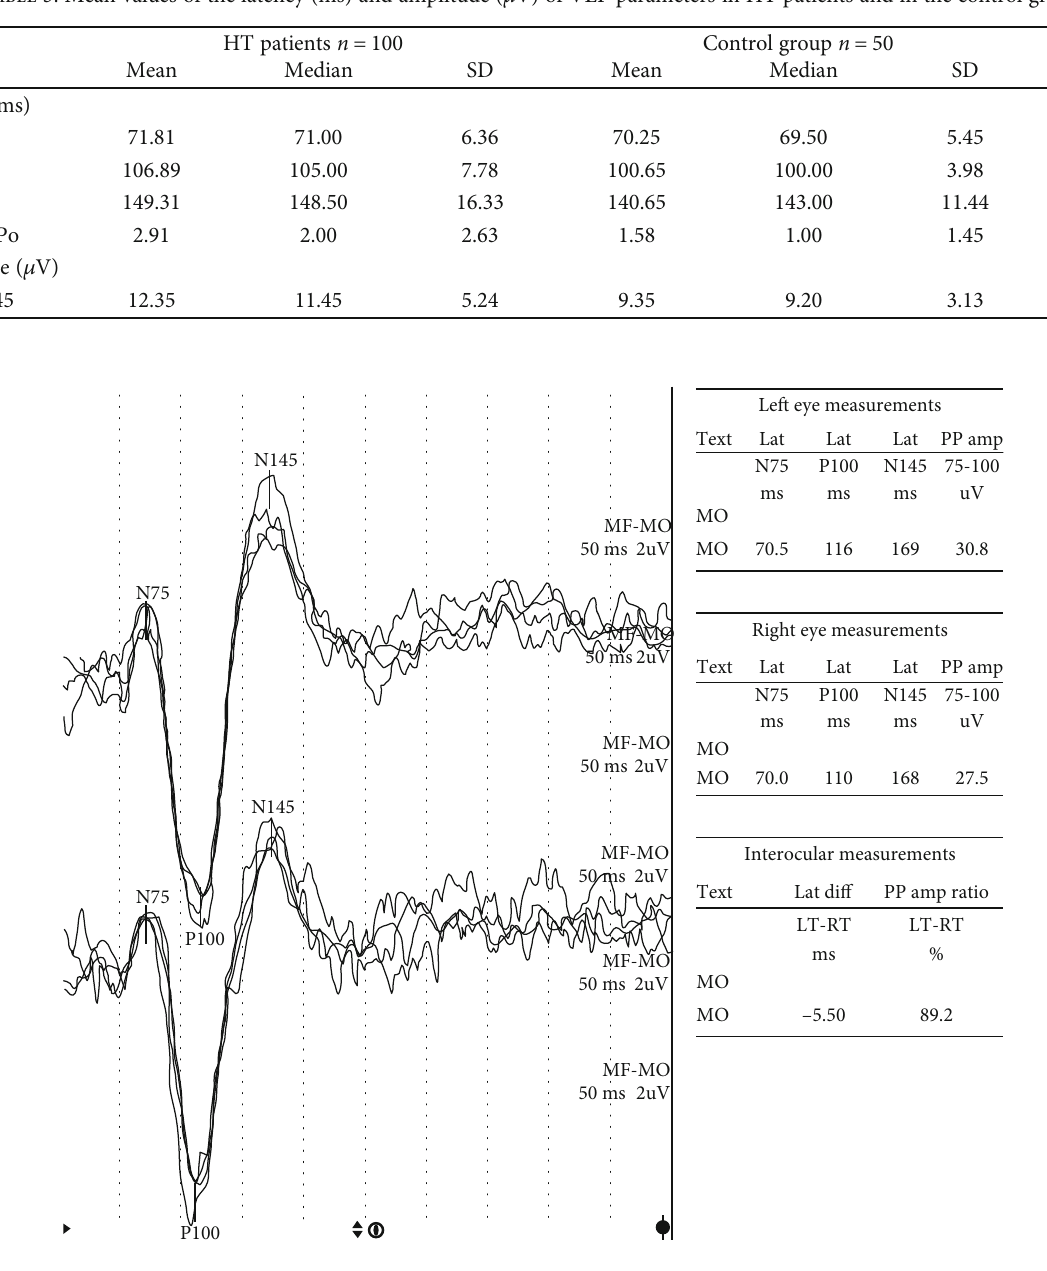
Table 3: Mean values of the latency (ms) and amplitude ( μ V) of VEP parameters in HT patients and in the control group.